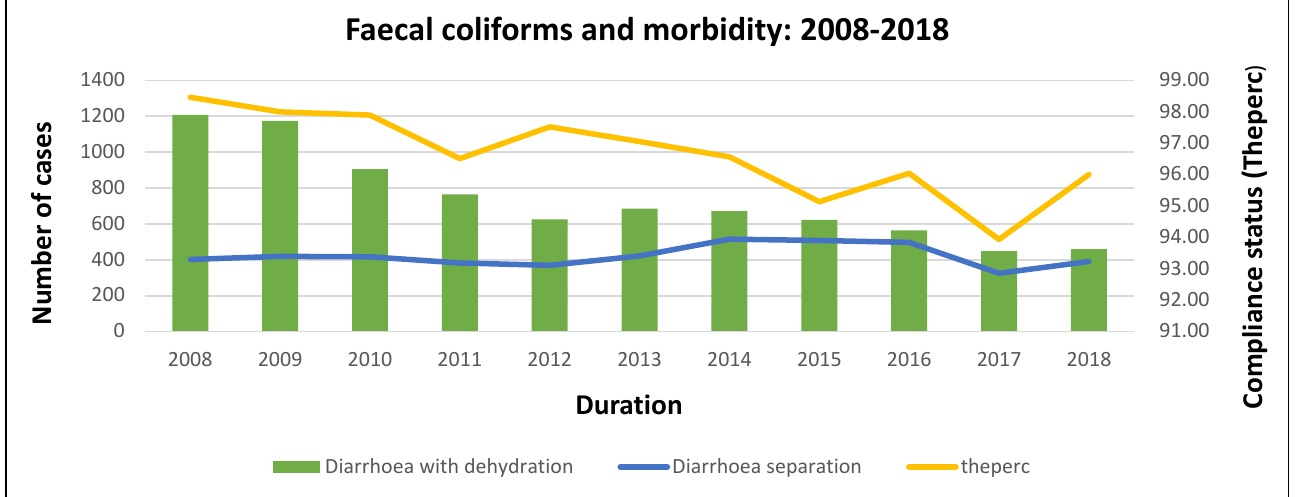
Figure 4. Faecal coliforms and morbidity trends at the national level. Figure 4 indicates that under 5 years mortality decreased from 2008 and reached a record low in 2018. Generally, compliance for Faecal coliform decreased up until 2015 and increased in 2016 before falling in 2017 and rising again in 2018 (an unsteady trend). As under 5 years mortality decreased from 2008 to 2011, compliance also decreased (a contrary trend), while an increase in compliance in 2012 saw a huge drop in under 5 years mortality. Compliance dropped towards 2013 and in 2014, which resulted in an increase in under 5 years mortality (Figure 5).